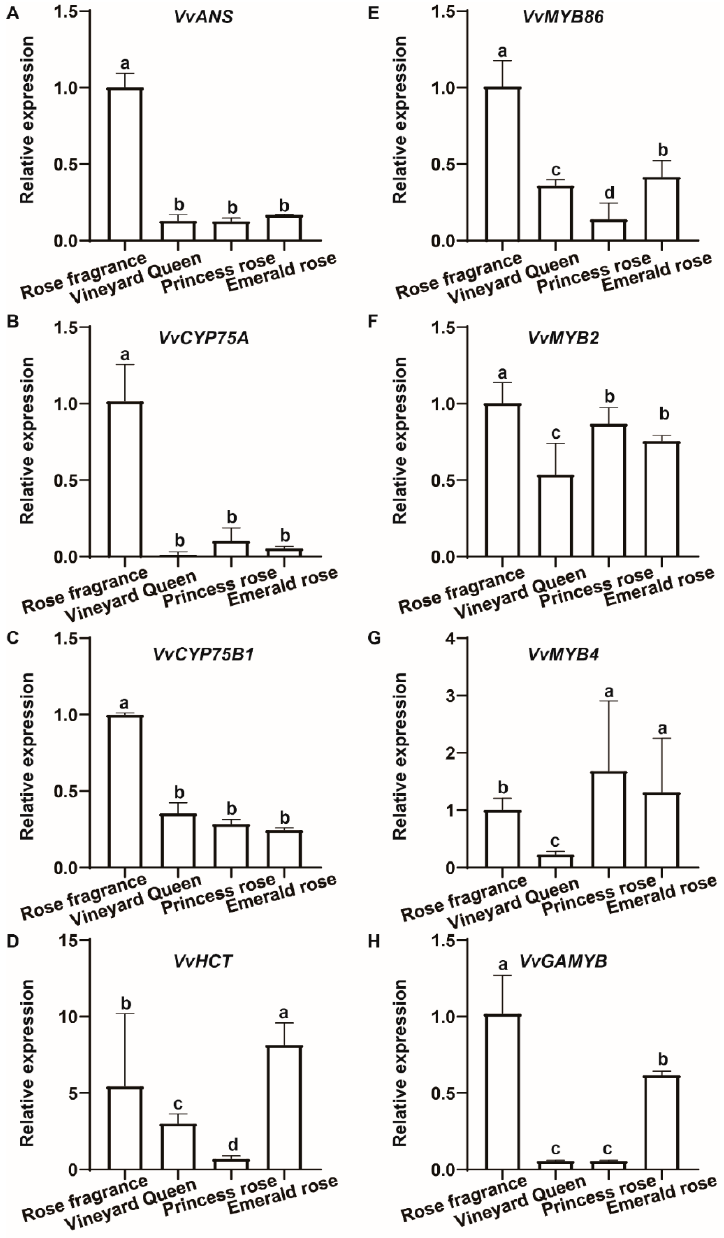
Figure 5. Relative expression of enzyme genes and transcription factors. ( A ) VvANS; ( B ) VvCYP75A; ( C ) VvCYP75B1; ( D ) VvHCT; ( E ) VvMYB86; ( F ) VvMYB2; ( G ) VvMYB4 (VIT_04s0023g03710); ( H ) VvGAMYB. Different lowercase letters indicate significant differences ( p < 0.05); n = 3.